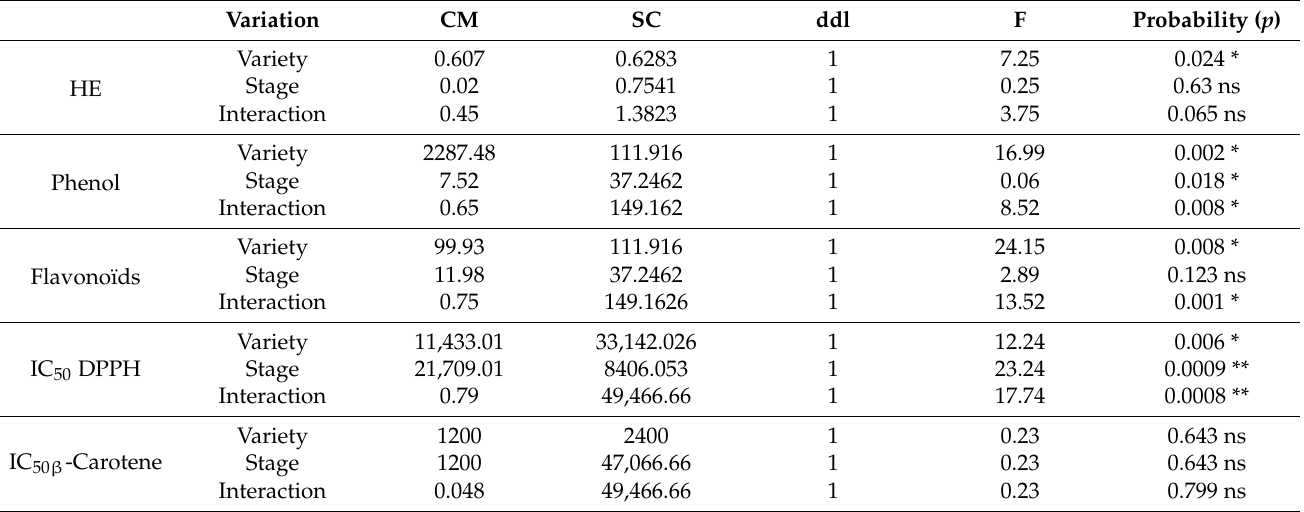
Table 4. ANOVA to two-way analysis of variance (variety and phenological stage) performed to different performed parameters measured for the two O. basilicum varieties. (**) ( p <